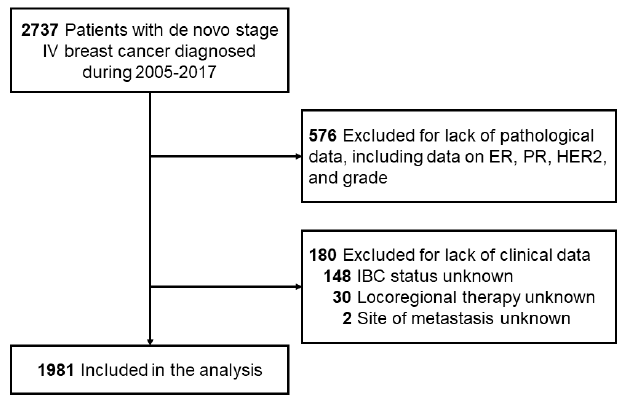
Figure 1. Patient selection process.